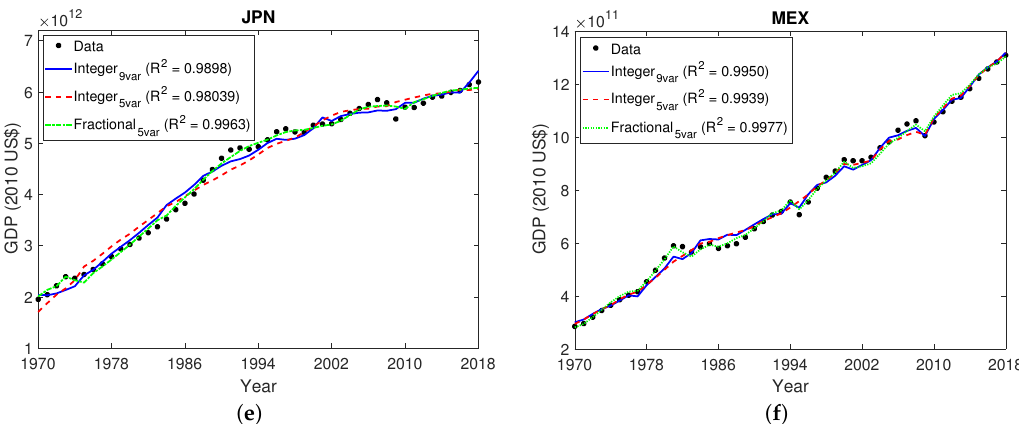
Figure 3. Results obtained with integer and fractional models for the following members of the G20: ( a ) Germany ( b ) India ( c ) Indonesia ( d ) Italy ( e ) Japan ( f ) Mexico. GDP estimations were obtained with integer models (1) and (2) and with fractional model (3). R 2 values are given to show the quality of the results of each model. As GDPs have different orders of magnitude, different scales were used in the y -axis for different countries.